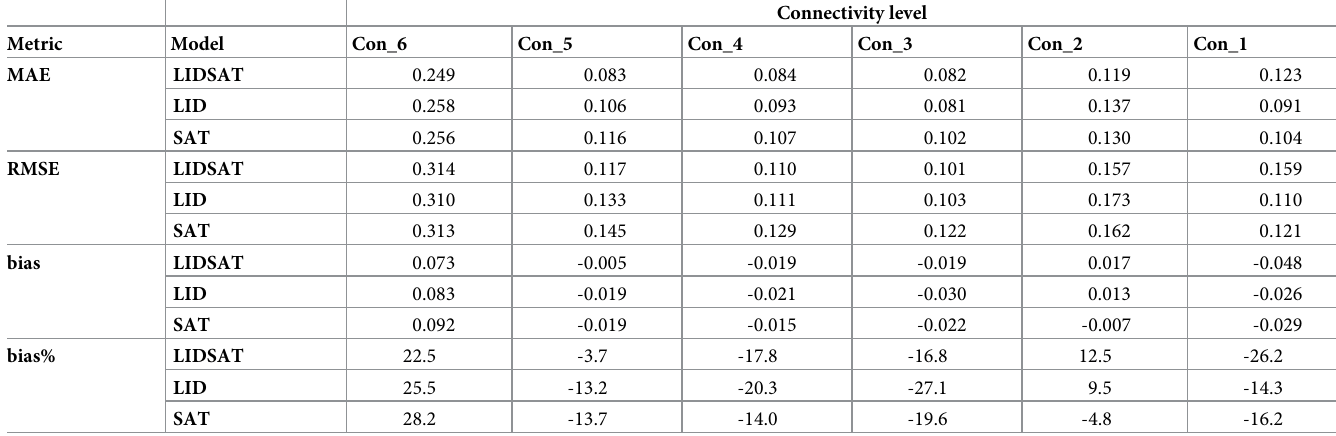
Table 9. Accuracy metrics calculated for each connectivity level using